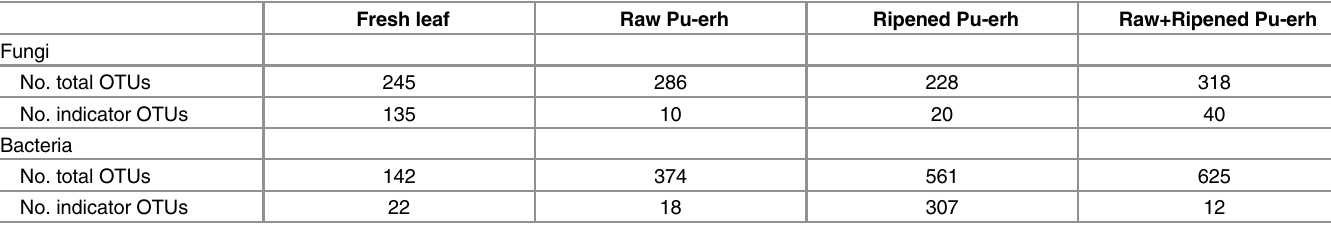
Table 2. Number of indicator fungal/bacterial OTUs detected for fresh leaf, raw and ripened Pu-erh samples. Fresh leaf Raw Pu-erh Ripened Pu-erh Raw+Ripened